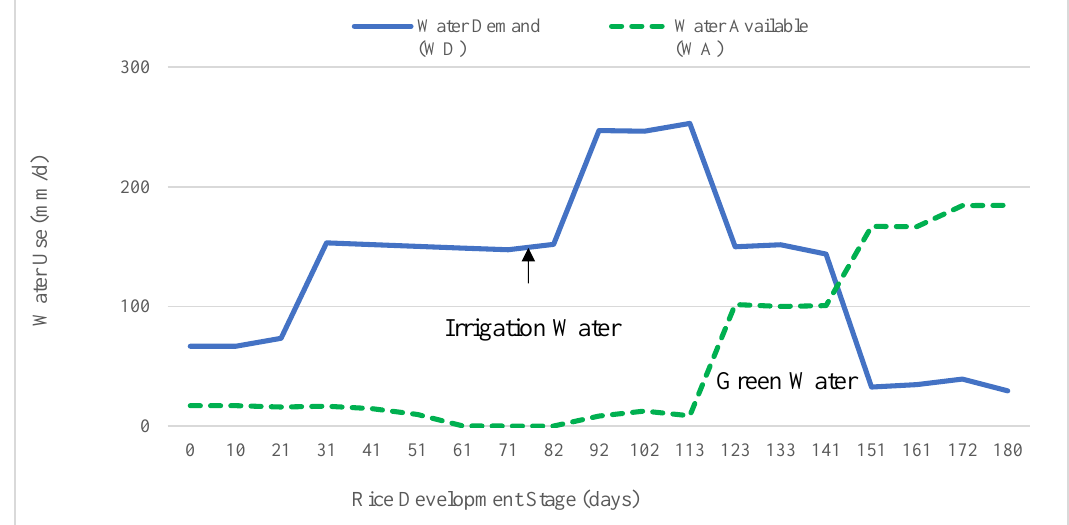
Figure A1. Graphical representation of water demand and water available for rice.